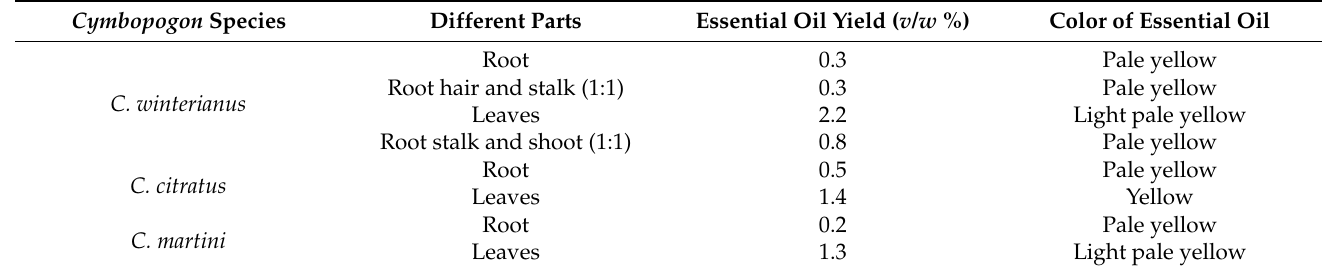
Table 1. Essential oil yields for different Cymbopogon species from hydro-distillation.